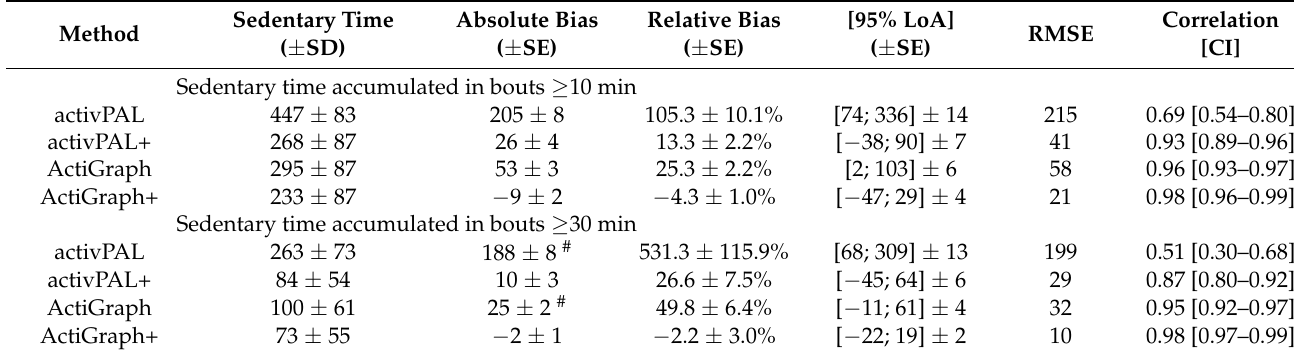
Table 2. Average sedentary time per day accumulated in bouts ≥ 10 and ≥ 30 min measured with each single-sensor method compared to